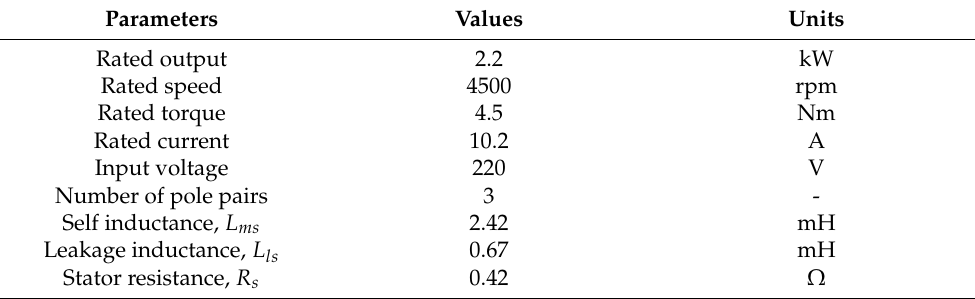
Table 1. Specifications of PMSM used in the experiments.